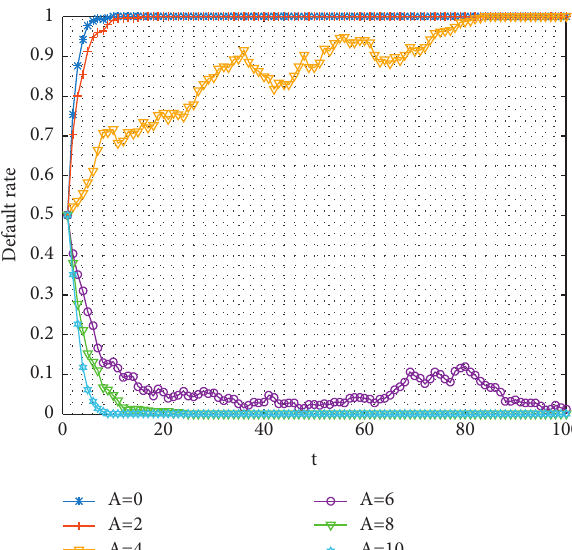
Figure 7: The effect of additional benefits on the spread of default behavior in s small-world